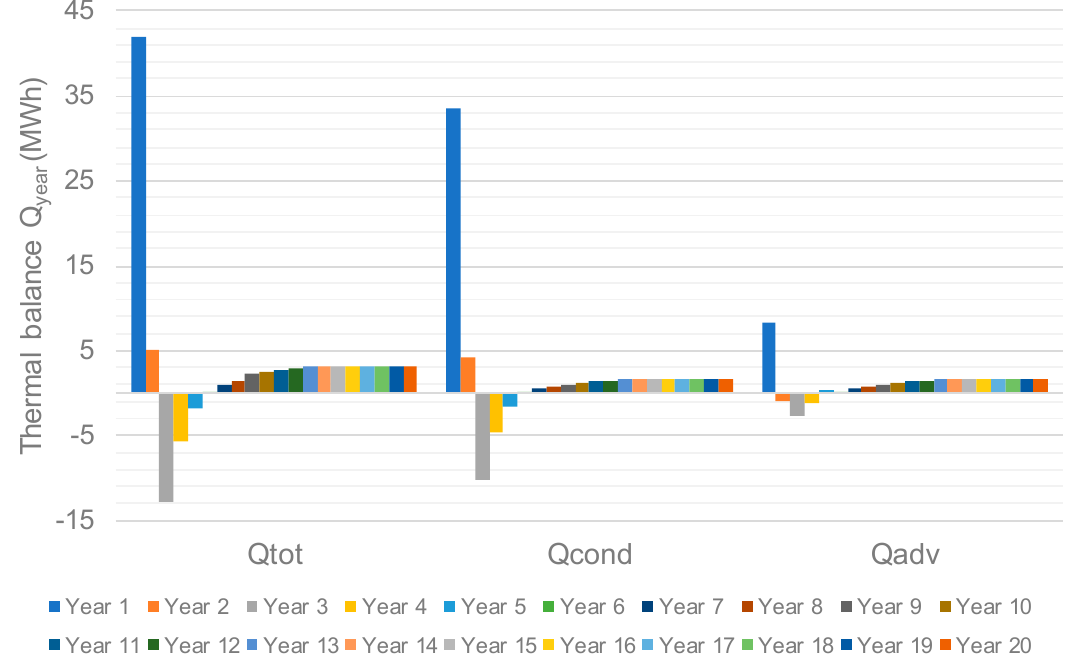
Figure 8. Thermal balance at the soil–structure interface for 20 years